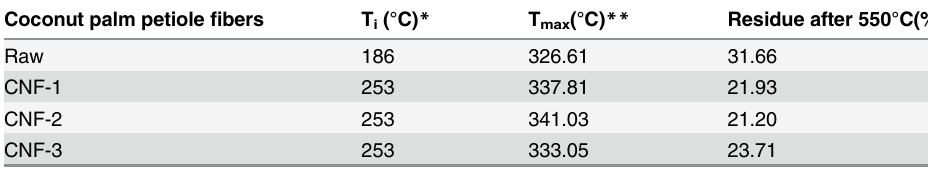
Table 4. Degradation characteristics of the coconut palm petiole fibers. Coconut palm petiole fi